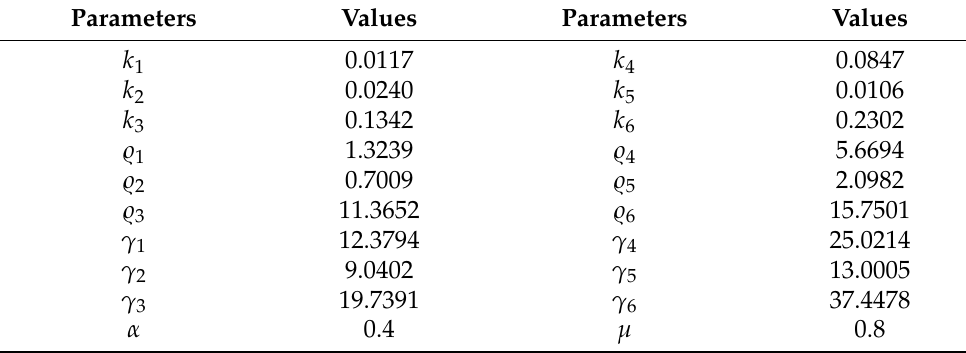
Table 3. Control system